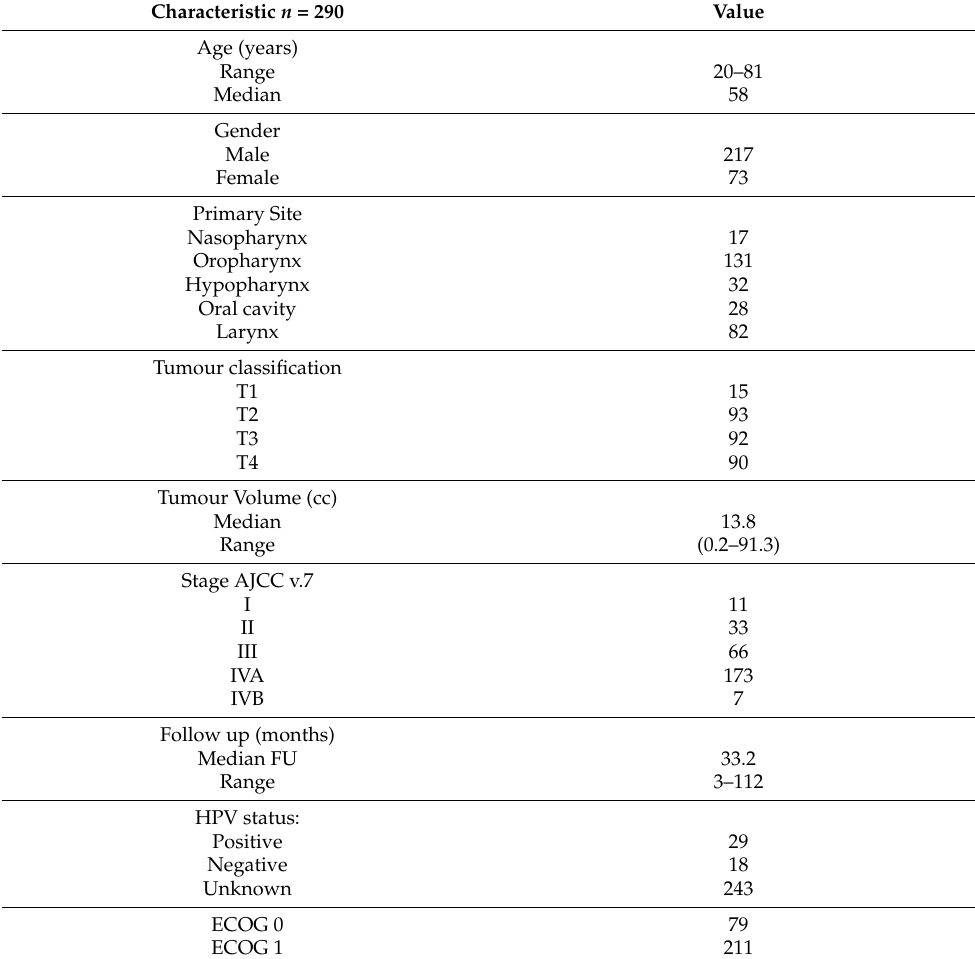
Table 1. Patients’